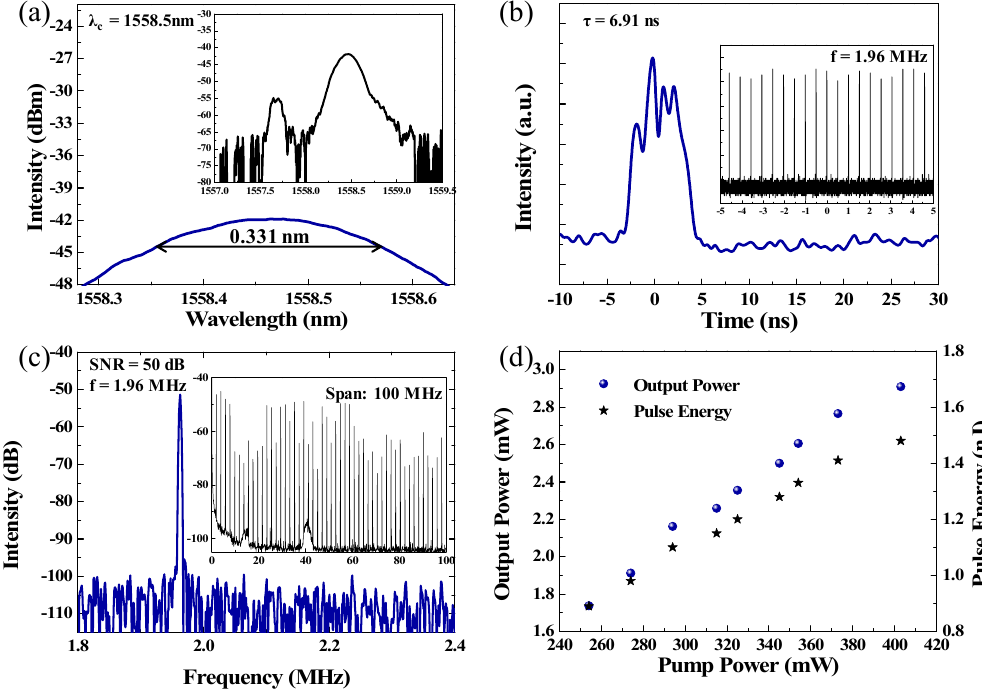
Figure 6. ( a ) The output optical spectrum, ( b ) a zoomed–in view of a single-pulse profile, and the inset is the pulse train, ( c ) RF spectrum (insert, RF spectrum with a bandwidth of 100 MHz range), and ( d ) output power of pulse and pulse energy versus power.